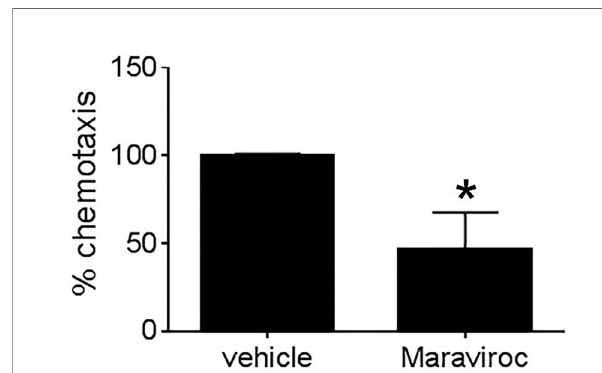
FIGURE 5 | Mammary fi broblast-induced breast tumor cell migration is blocked by CCR5 inhibitor Maraviroc. Graph shows results from Boyden chamber assays of MDA-MB231 cell chemotaxis. Mammary fi broblast- conditioned media was used as a chemoattractant and includes either Maraviroc (10µM) or an equal volume of vehicle. The data represented in graphs are derived from at least three independent experiments. *p < 0.05 against control by t-test.